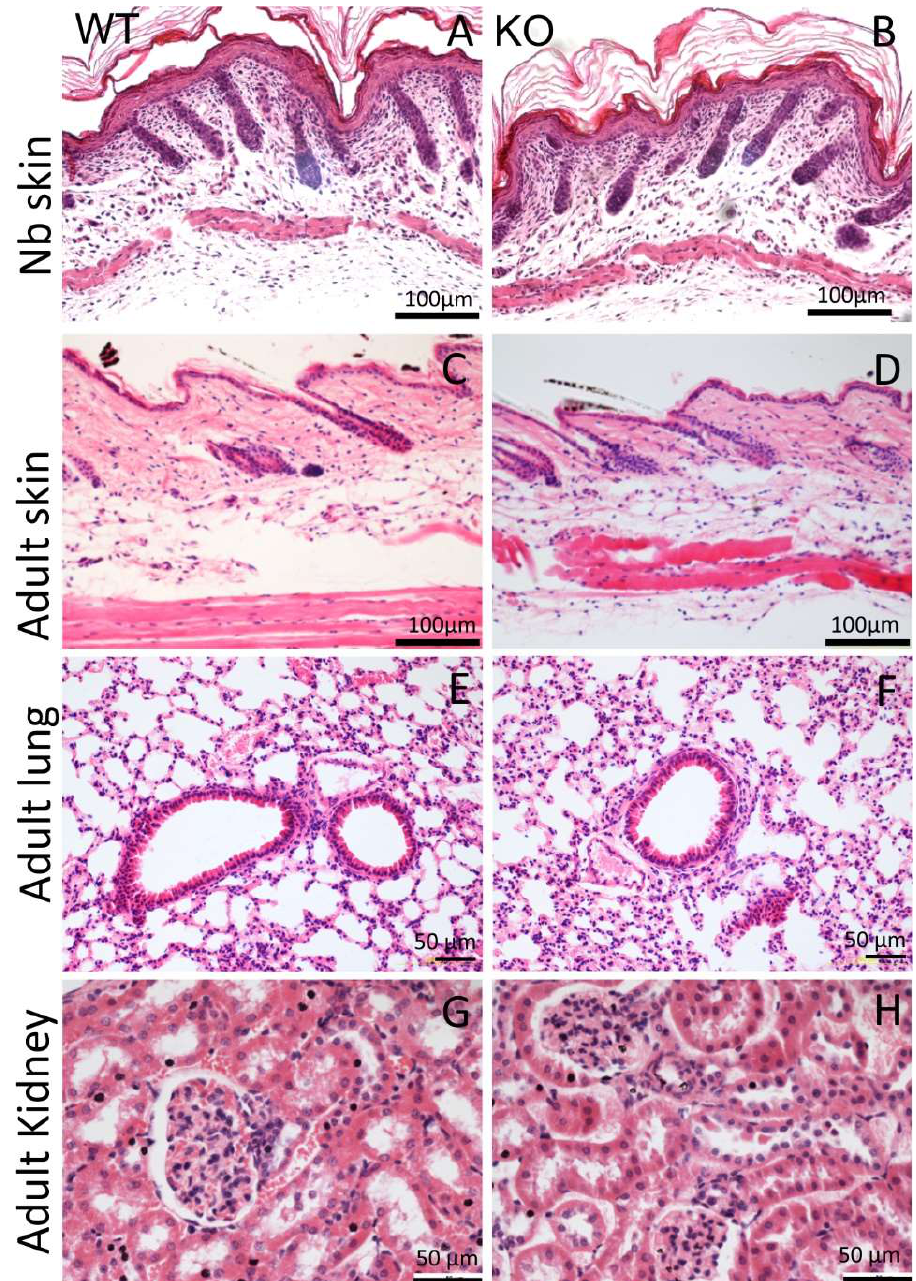
Figure 2. Histological analysis of AMACO-expressing tissues. Hematoxylin/eosin staining of paraffin-embedded sections displayed normal tissue architecture in the AMACO-deficient newborn ( B ) and adult ( D ) skin, and adult lung ( F ) and kidney ( H ). Wildtype controls ( A , C , E , G ). Scale bars = 100 µm in ( A – D ) and 50 µm in ( E – H ).